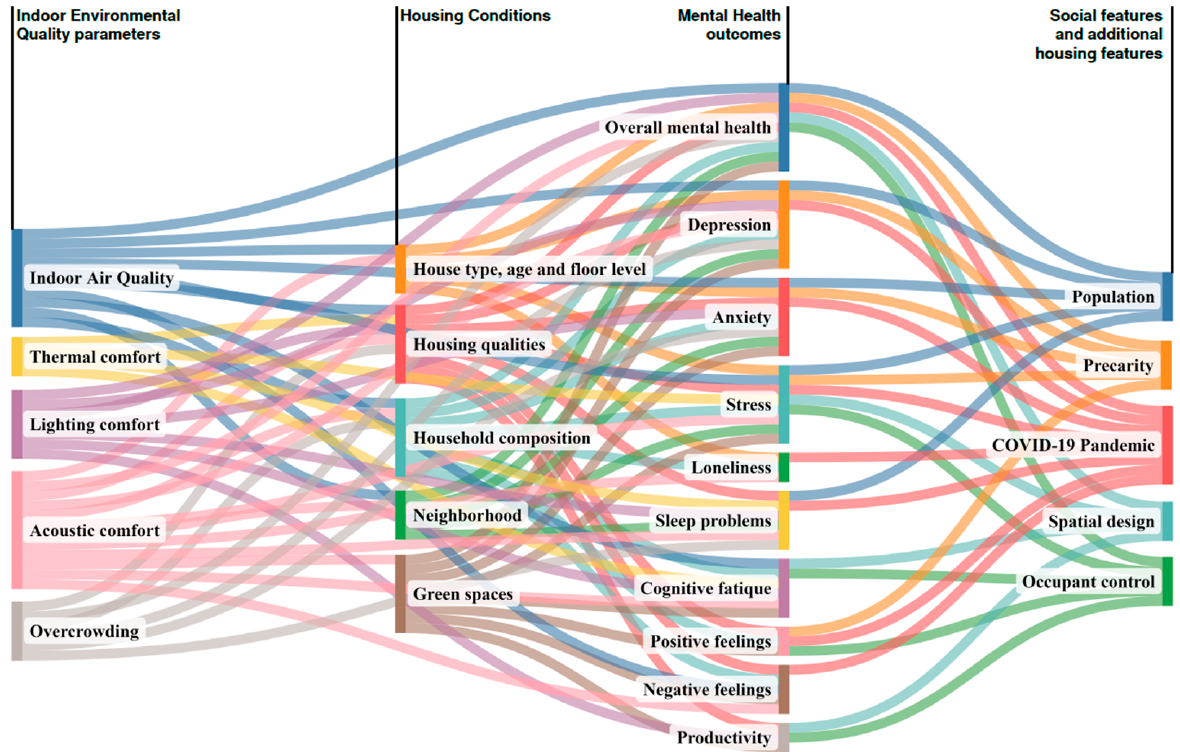
Figure 7. Correlation among IEQ, housing conditions, mental health outcomes and social features, and additional housing features.